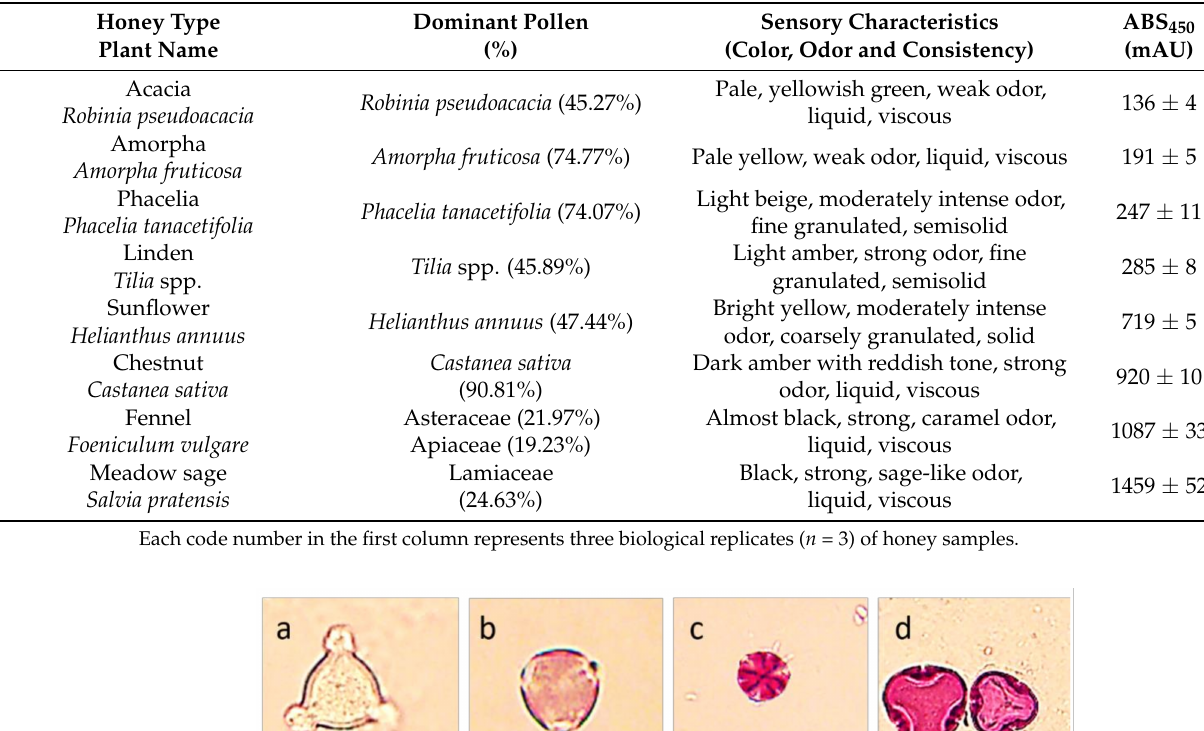
Table 1. Identification and sensory characteristics of analyzed honey samples.